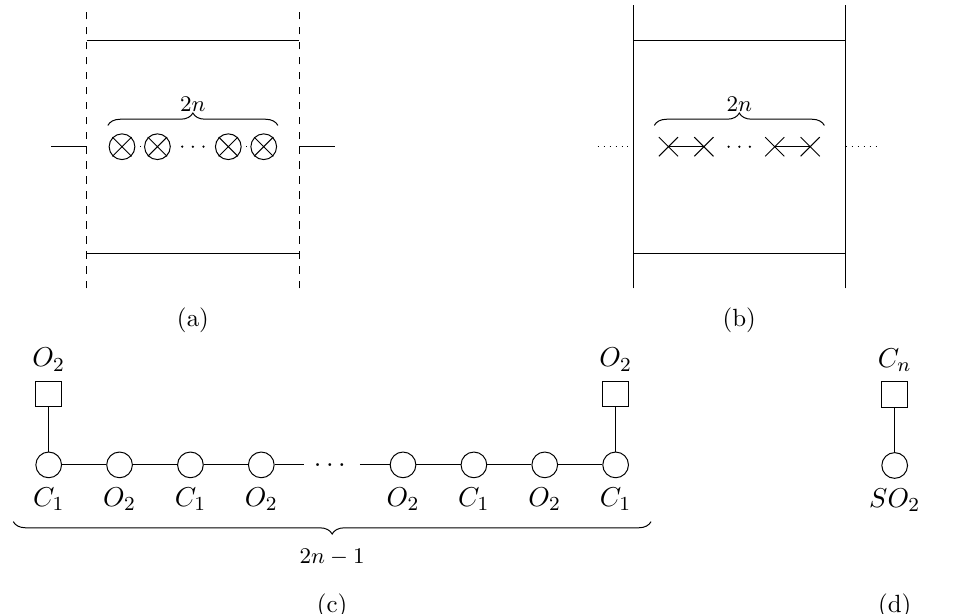
Figure 57. A [ A 2 n (cid:0) 1 2 n (cid:0) 1 subregular singularity. (a) Brane subsystem that represents the gen- eralization of the moduli space in (cid:12)gure 25(a). (b) After S-duality the moduli space generated by this single D3-brane as a Coulomb branch. (c) Quiver corresponding to brane system (a), its Higgs branch is M H = A 2 n (cid:0) 1 [ A 2 n (cid:0) 1 . (d) Quiver corresponding to brane system (b), its Coulomb branch is M C = A 2 n (cid:0) 1